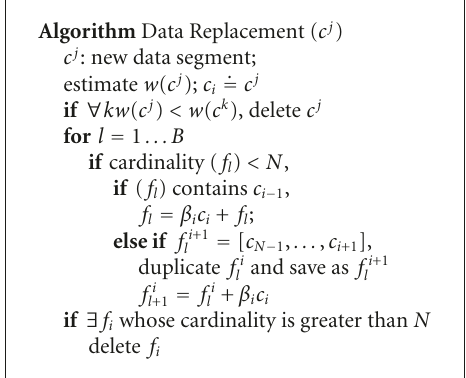
Algorithm 1: Pseudocode for data